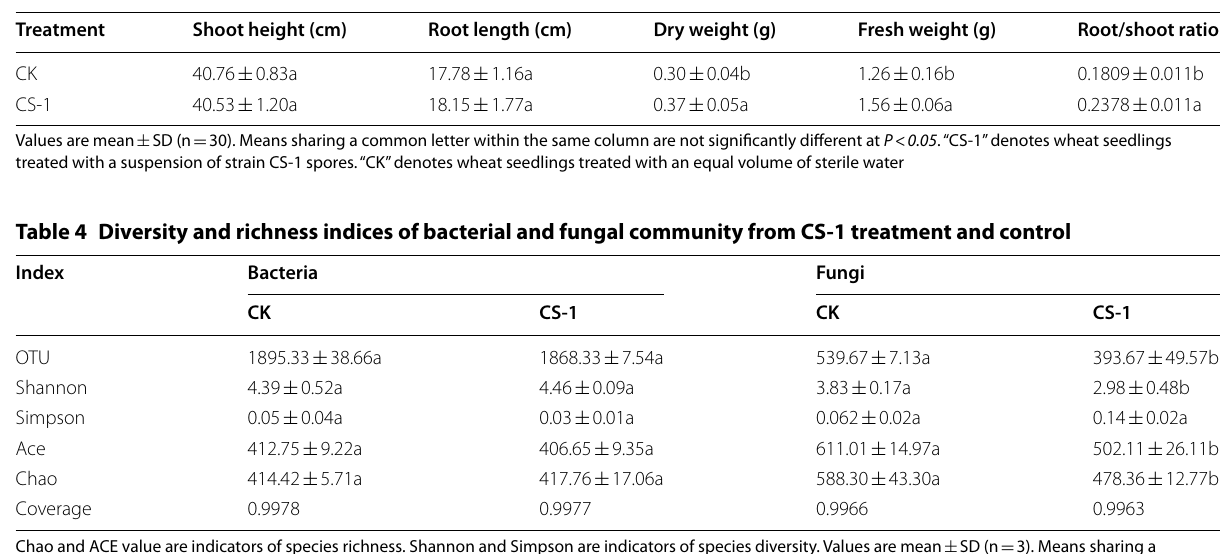
Values are mean SD (n 3). Means sharing a common letter within the same column are not significantly different at P < 0.05 ± = Table 3 Effect of the CS-1 strain on growth parameters of wheat seedling